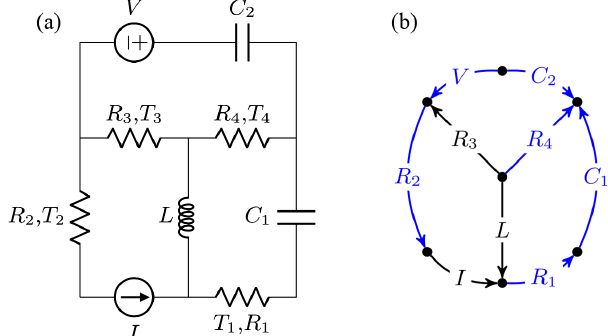
FIG. 1. (a) A circuit in which different resistors are at different temperatures. (b) Its associated graph, with a normal tree indicated in